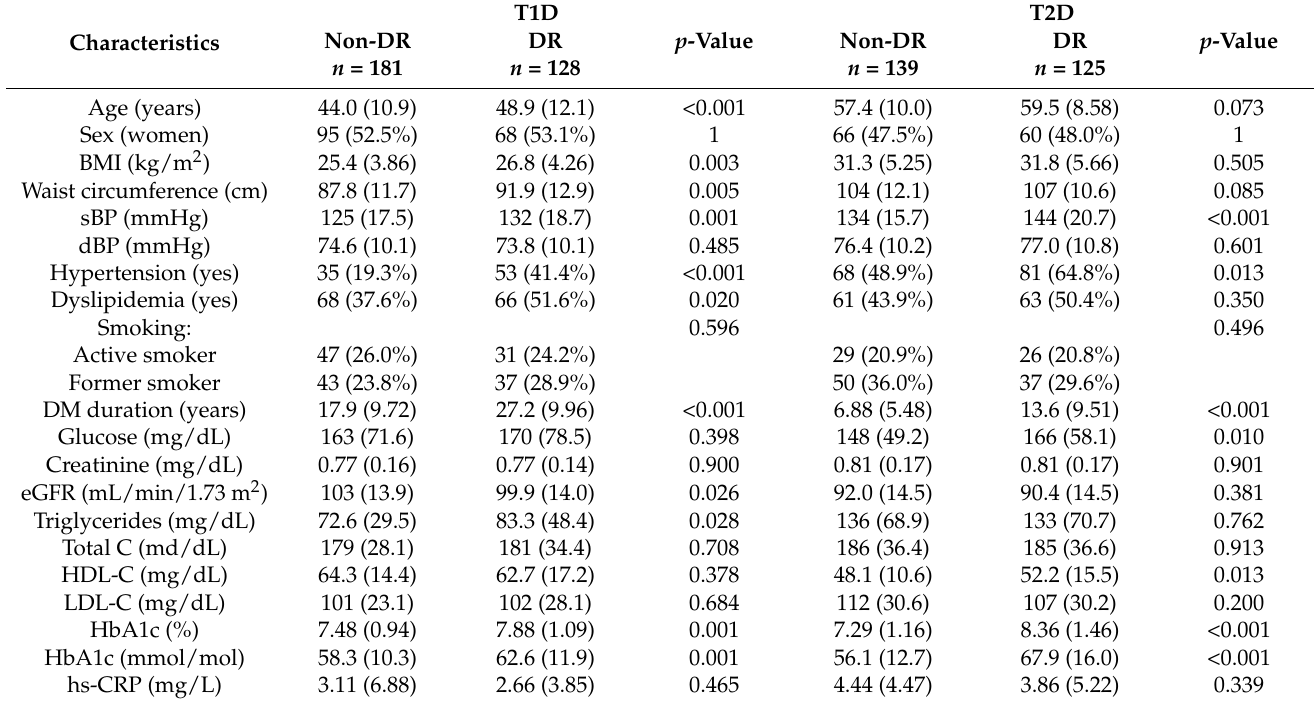
Table 1. Clinical characteristics according to diabetes type and presence or absence of diabetic